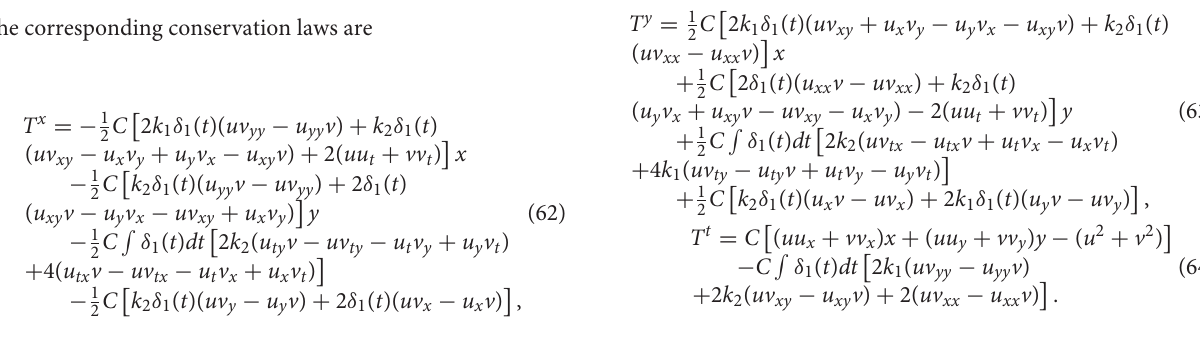
k 2 k 3 1, C 2 2, k 1 1 at t 0. (A) Perspective view of the solution u . (B) Perspective view of the solution v = = = = = =